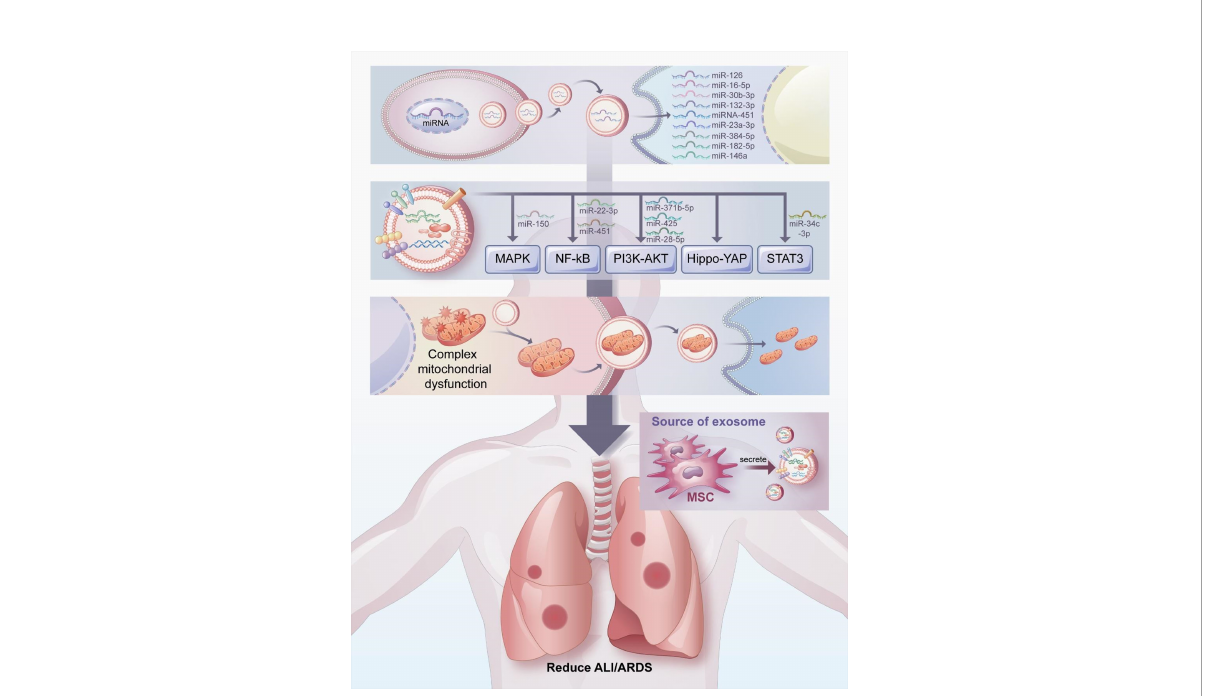
FIGURE 3 Mechanisms by which exosomes attenuate ALI/ARDS and thus exert pulmonary protective effects. The potential therapeutic mechanisms of exosomes in the treatment of ALI/ARDS include transferring miRNA, participating in signal pathway transduction, and regulating mitochondrial